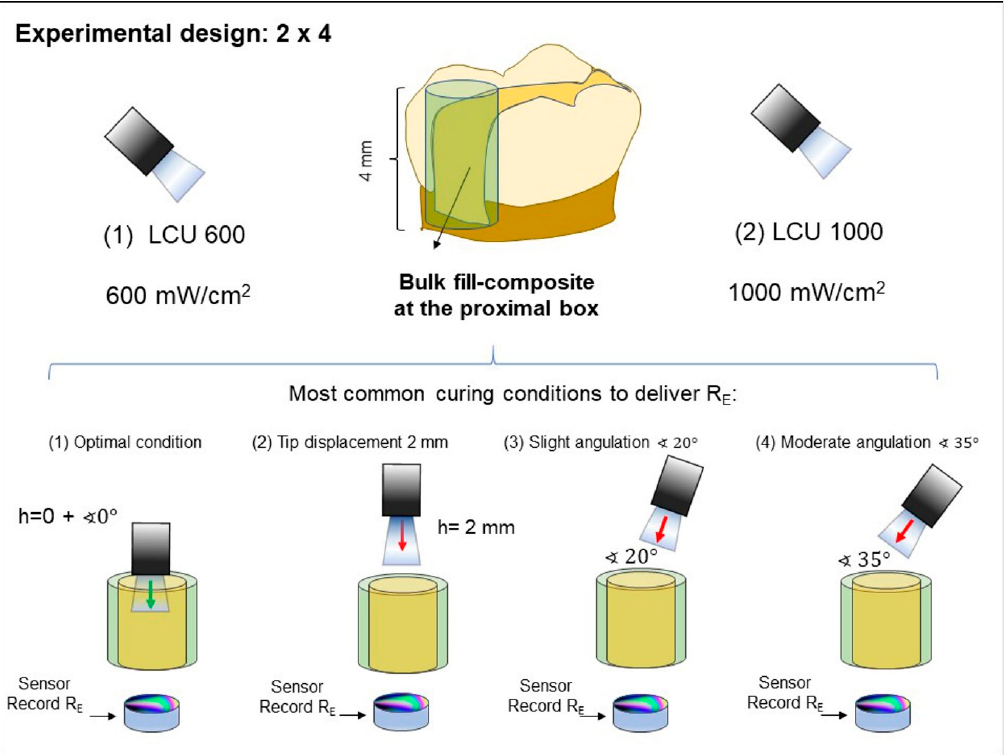
Figure 1. Schematic representation showing the most clinical conditions during the light-curing procedure, which was simulated in this experiment. The 4-mm increment was placed similar to that one placed in the proximal box of a Class II preparation. Then, the following simulated conditions: ( 1 ) optimal condition (no angulation or tip displacement), ( 2 ) tip-displacement (2 mm), ( 3 ) light tip angulation ( α = 20 ◦ ) and ( 4 ) light tip angulation ( α = 35 ◦ ) were performed, and the R E values were